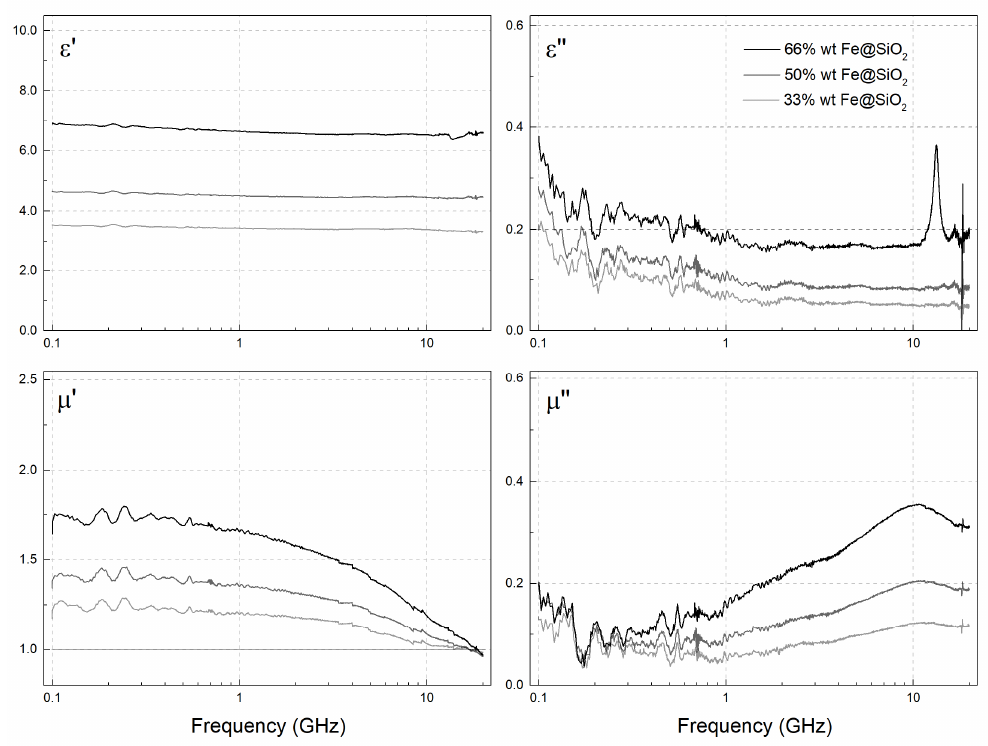
Figure 8. The measured frequency dependences of microwave permeability ( μ′ + i · μ″ ) and permittivity ( ε′ + i · ε″ ) of the composites comprising the paraffin wax matrix and “Fe@SiO 2 “powder.